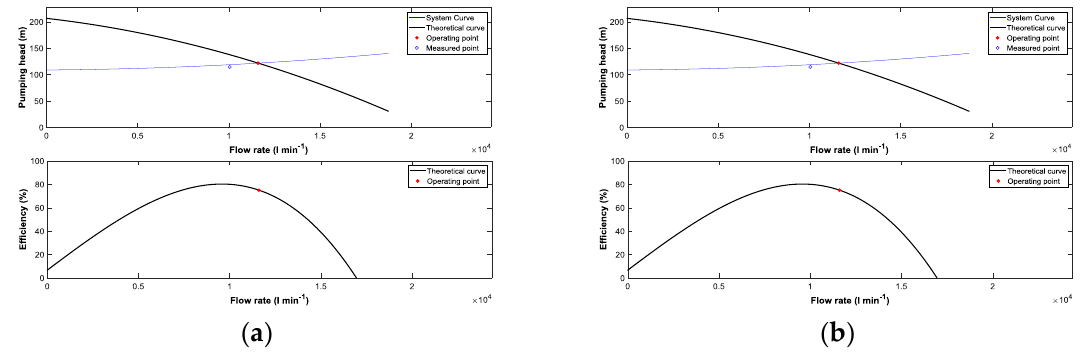
Figure 9. Operating point at fixed speed in WUA A for Case 2 in 2008 ( a ) and 2015 ( b ) irrigation seasons.